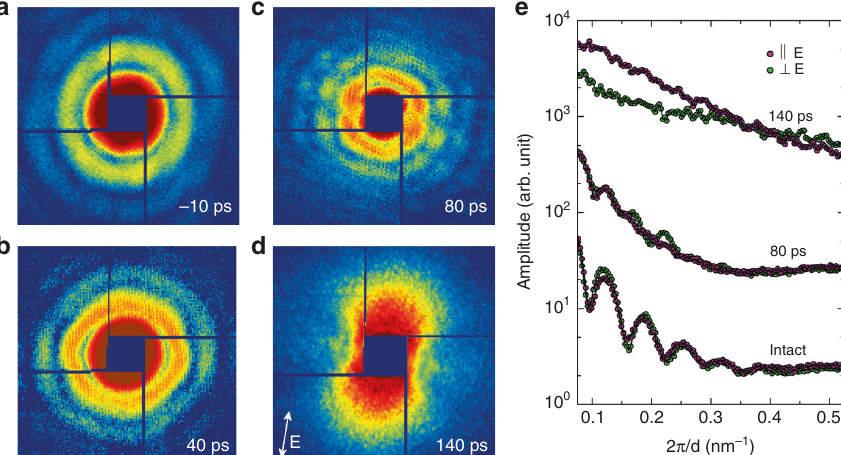
Fig. 2 Time resolved single-shot speckle patterns using femtosecond X-ray laser. a – d Single-shot coherent diffraction patterns from single Au nanoparticles are displayed showing anisotropic distortion in the speckle pattern with the melting in progress. e Line plots along the directions parallel and perpendicular to the laser polarization are compared. On melting, the fringe oscillation smears out more strongly along the polarization direction (80 ps) and eventually higher diffuse scattering signal is detected on complete melting at 140 ps ( e ). The polarization direction of the IR pump laser is shown with the arrow in